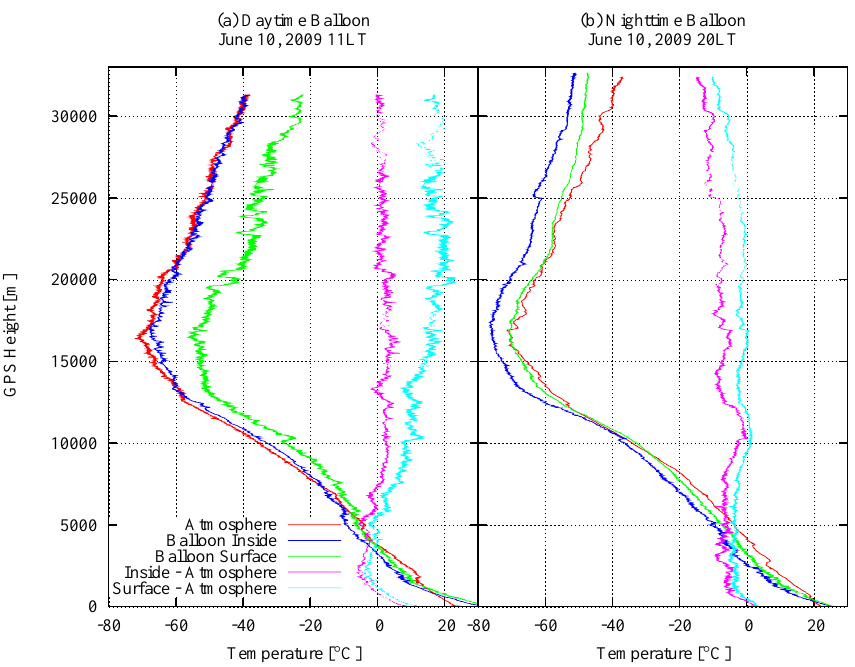
Fig. 10. Vertical profiles of the balloon’s inside (green), outside (red) and the surface (blue) temperature ( ◦ C) obtained by thermistors during the daytime (left) and nighttime (right) soundings at Moriya, Japan on 10 June 2009. Those in purple and light blue are the temperatures of balloon’s inside and surface, respectively, relative to the outside. 1200-gr balloon was used for both flights.